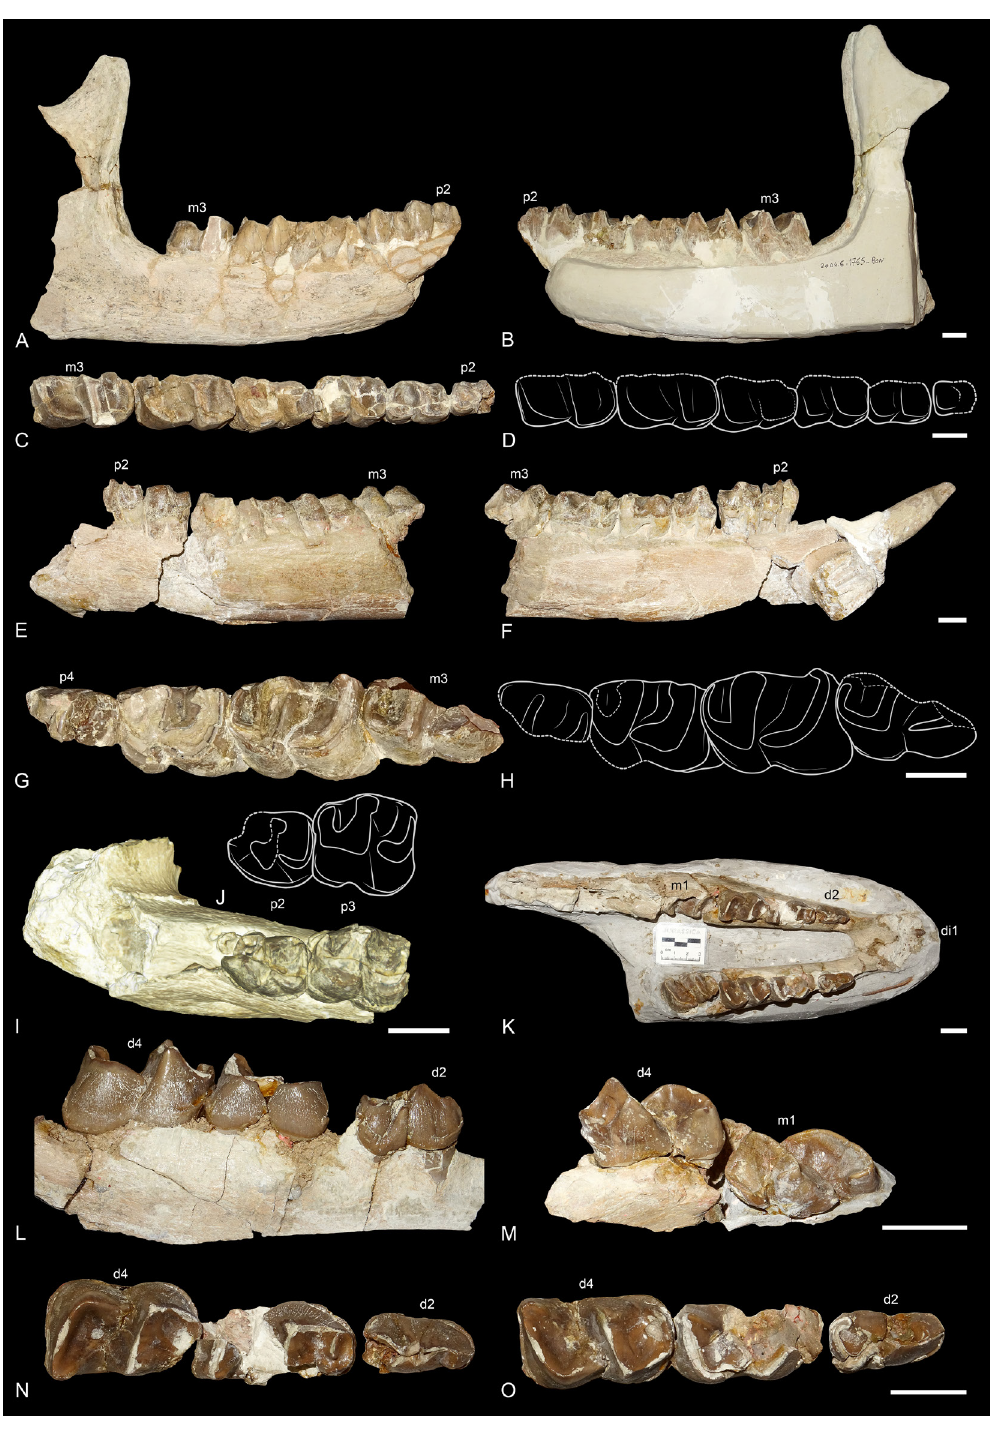
Fig. 2. Ronzotherium velaunum (Aymard in Pictet, 1853) from Ronzon (earliest Oligocene, France). – A–D . Lectotype right hemimandible PUY.2004.6.1765.RON with p2–m3. A . Lateral view. B . Medial